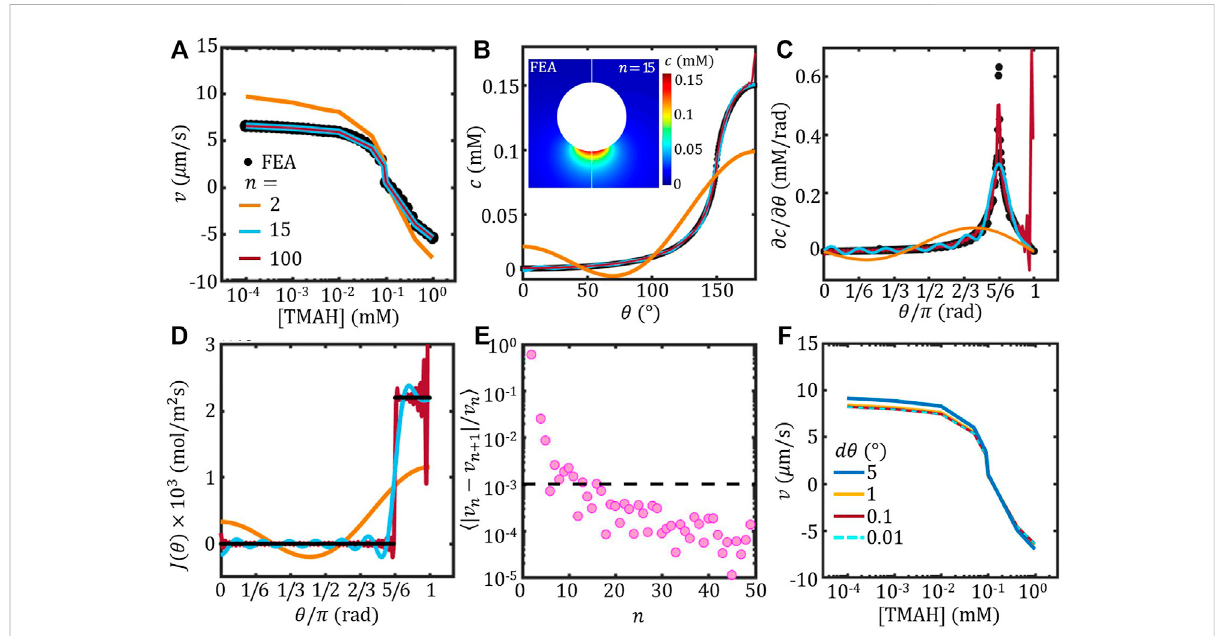
FIGURE 3 Theself-propulsionvelocityofasphericalJanuscolloidestimatedusingLegendreexpansion. (A) Velocityasafunctionof[TMAH]withdifferent order n (lines). The FEM result of a spherical Janus is re-plotted from Figure 2C (circle). (B – D) Concentration c at the surface (B) , the corresponding tangentialconcentrationgradient z c / z θ (C) andsurface fl ux J ( θ ) (D) asafunctionof θ evaluatedusingFEMandLegendreexpansionofvaryingorder n . Inset of (B) shows the comparison of the concentration fi eld of a spherical Janus colloid evaluated using FEM (left) and Legendre expansion to the order of n = 15. (A) – (D) share the same legend. (E) The variance of velocity between successive order n , 〈 | v n − v n +1 |/ v n 〉 , as a function of n (F) Velocity estimated with varying θ resolution d θ